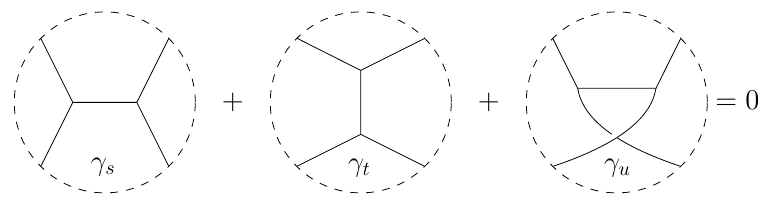
Figure 1 . Graphs related by BCJ